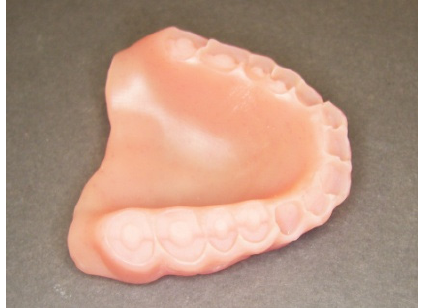
Figure 18. Milled denture base with shaped teeth sockets.